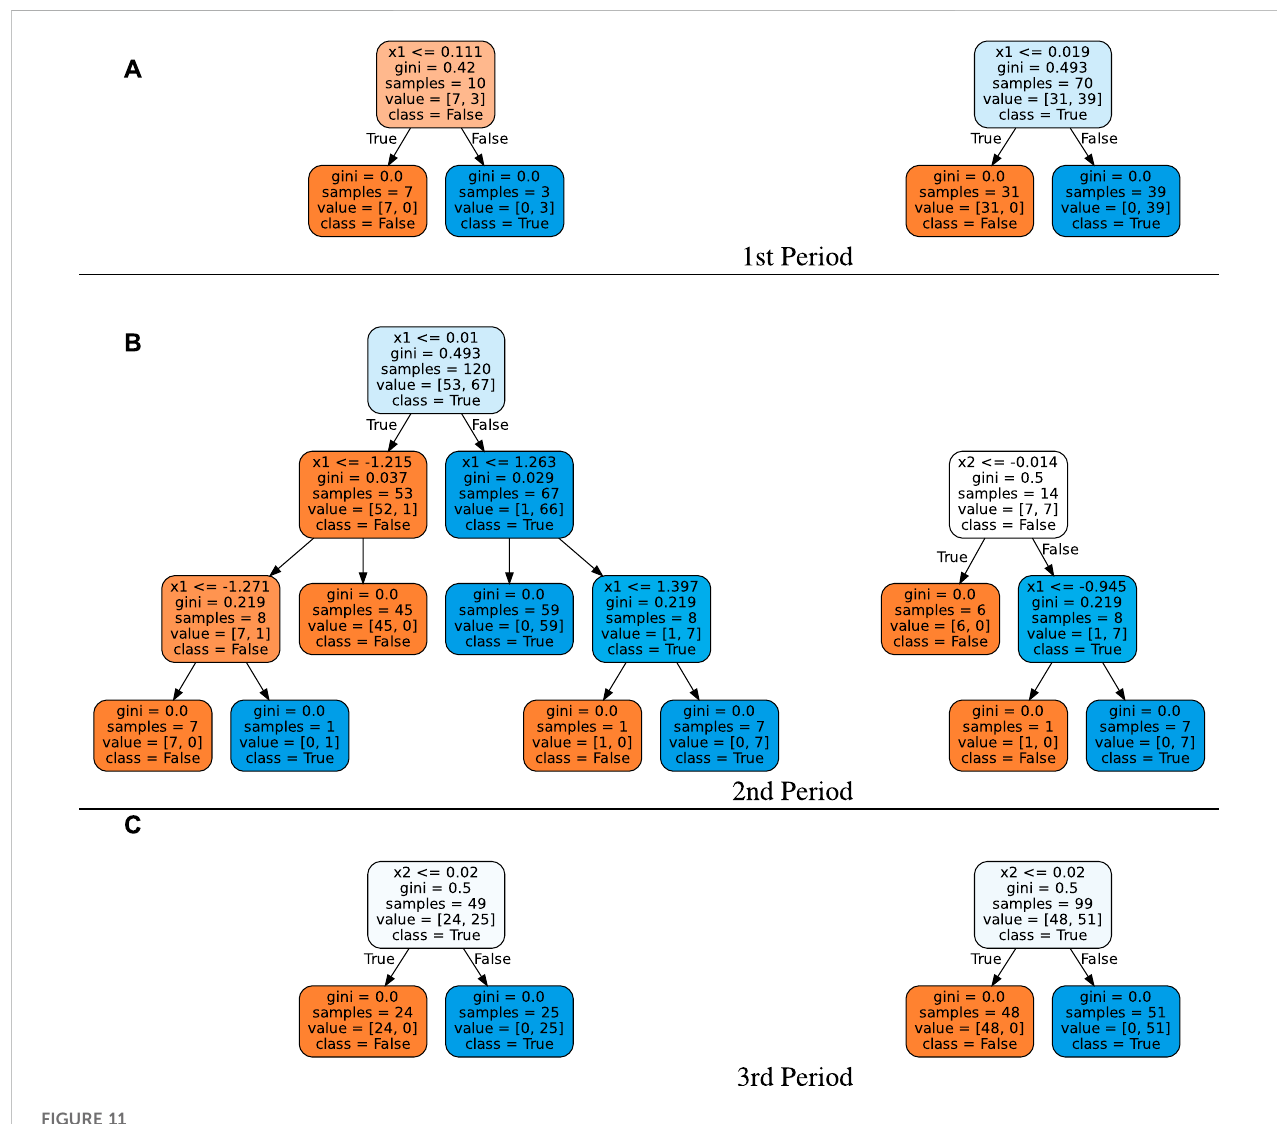
FIGURE 11 Tree Models for each Period. (A) 1st Period. (B) 2nd Period. (C) 3rd